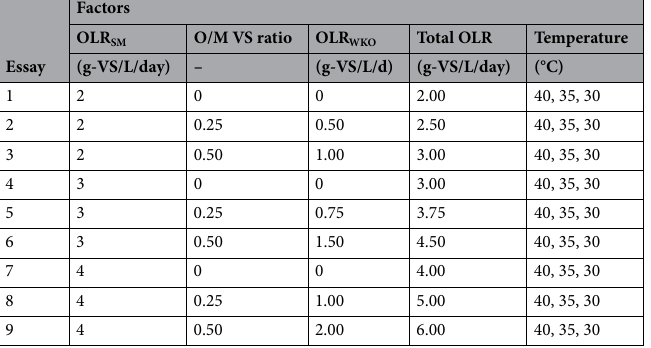
Table 1. Experimental design in the study. OLR organic loading rate, SM swine manure, VS volatile solid, O/M